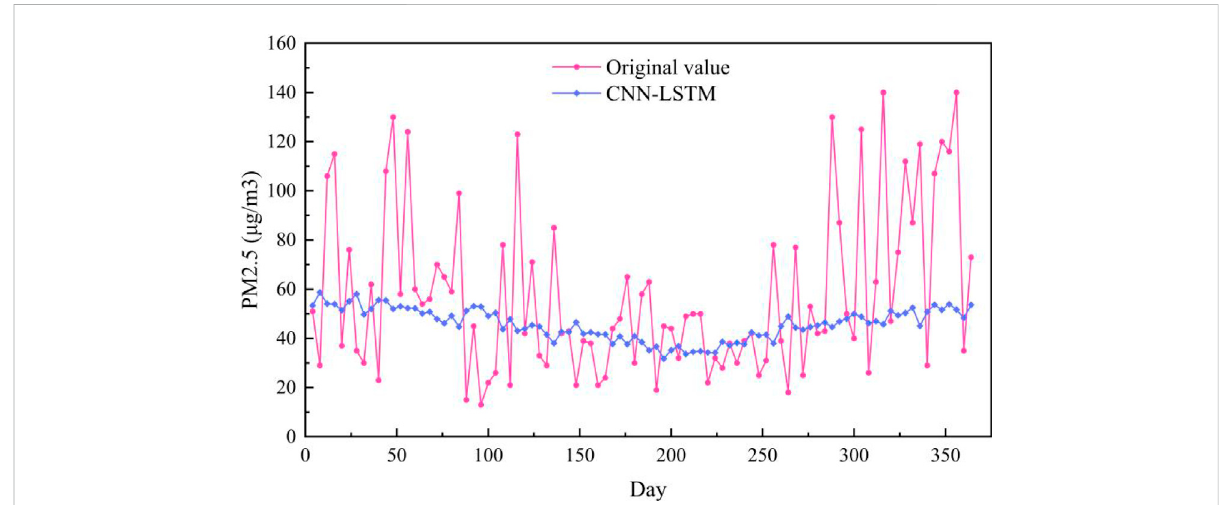
FIGURE 9 Experimental results of CNN-LSTM method in Baoding test set.